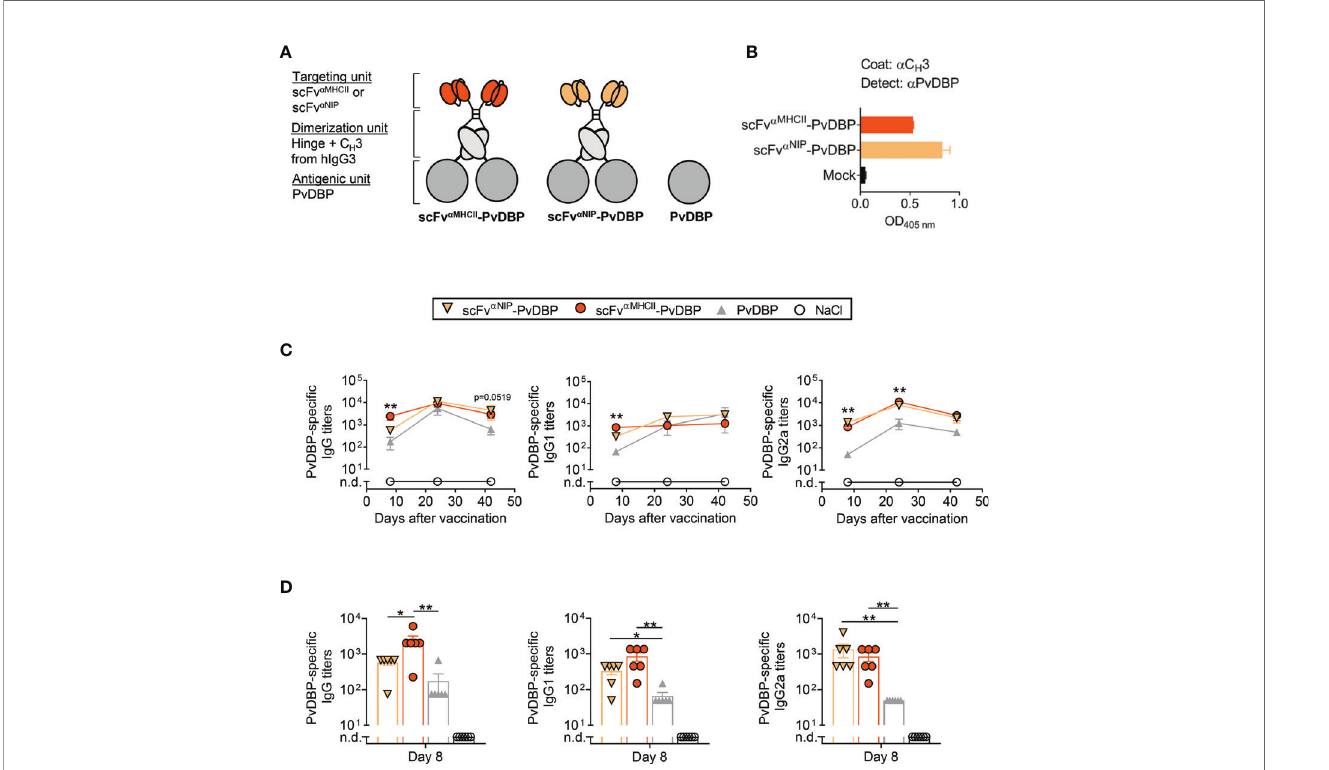
FIGURE 6 | PvDBP-containing scFv a MHCII -targeted DNA vaccines induced antigen-speci fi c antibody responses in mice after one vaccination. (A) Schematic representation of dimeric PvDBP-containing vaccine proteins. The targeted vaccines (scFv a MHCII , targeting unit orange), the non-targeted control (scFv a NIP , yellow), and the PvDBP as the antigenic unit (dark grey). In addition, a vaccine plasmid only expressing the PvDBP was included. (B) HEK293E cells were transiently transfected with scFv a MHCII – targeted and non-targeted (scFv a NIP ) DNA plasmids containing PvDBP, and vaccine proteins in supernatant were detected by indicated sandwich ELISAs. (C, D) BALB/c mice were vaccinated once with 5 µg DNA i.m./EP with the indicated DNA vaccines or NaCl. (C) Serum samples were assayed for PvDBP-speci fi c total IgG, IgG1 and IgG2a at day 8, 24, and 42 against PvDBP in ELISA, shown as mean ± SEM. Stars indicate statistical signi fi cance between the scFv a MHCII -PvDBP group and the PvDBP antigen alone group. (D) Individual mice and mean ± SEM at day 8 are shown, n = 6/group, *p < 0.05, **p < 0.01, two- tailed Mann-Whitney. n.d., not